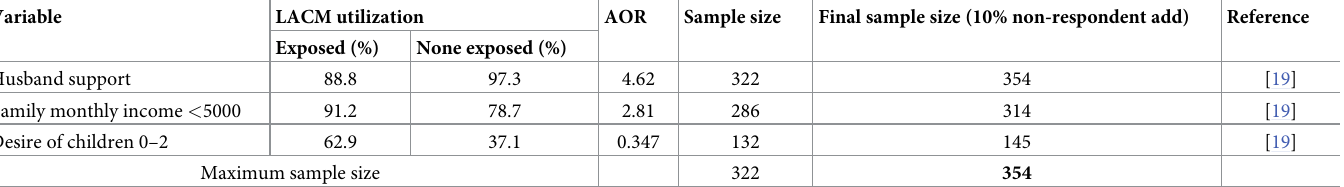
Table 1. Sample size determination for factor associated with utilization of LACMs service using studies, 2021.